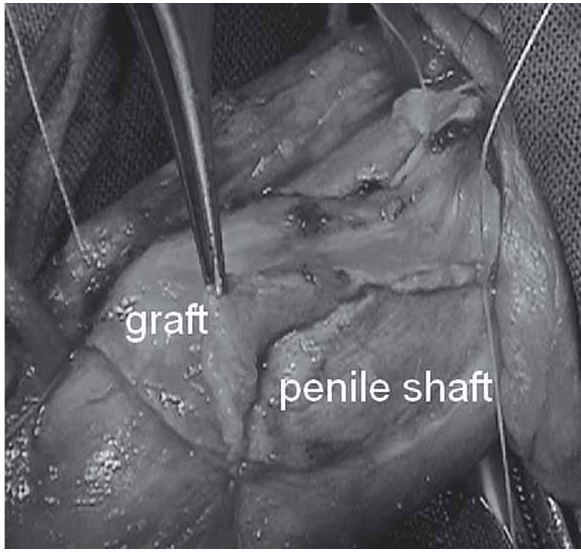
Figure 5 - The tunical graft sutured over the penile defect. Figure 6 - Artificial erection to check the